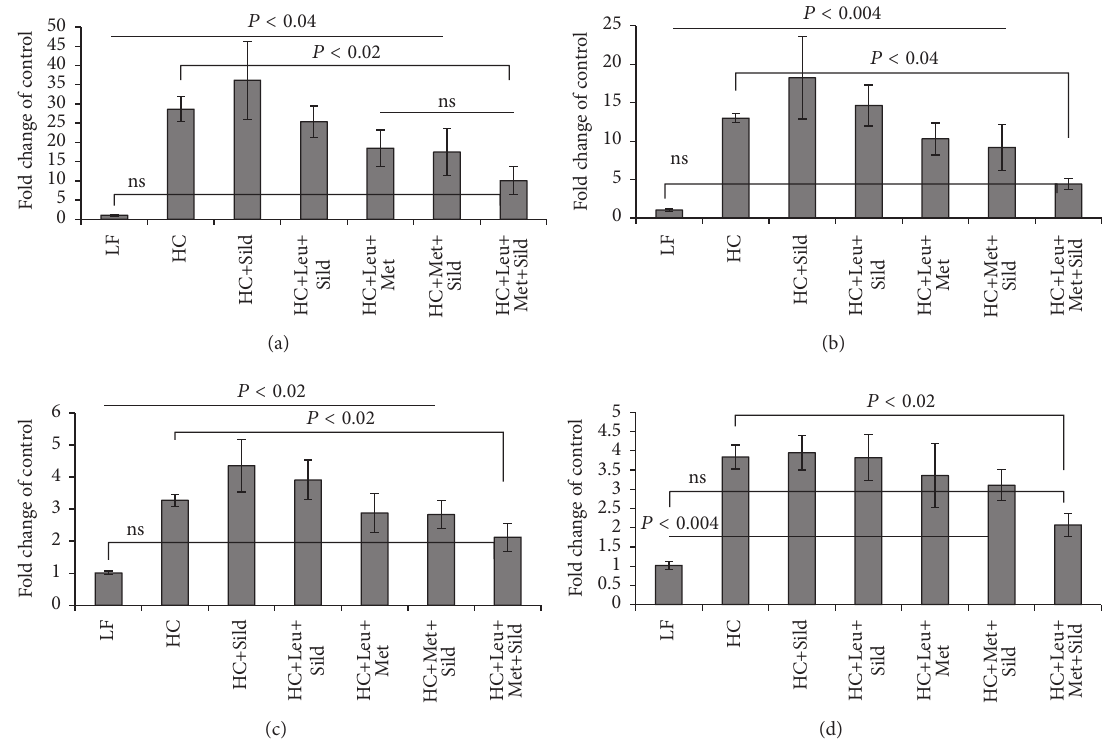
Figure 11: Sild-Met-Leu effects on fibrosis marker in mice. Mice were fed a low-fat (LF) diet or high-fat atherogenic (HC) diet for 6 weeks and then randomized to the indicated treatment groups for an additional 6 weeks. Gene expression of the collagens (a) Col1a1, (b) Col1a2, (c) Col4a1, and (d) transforming growth factor- (TGF-) beta was measured in liver extracts and expressed as mean ± SEM of fold change of control ( 𝑛 = 6 ). Sild: sildenafil, Met: metformin, Leu: